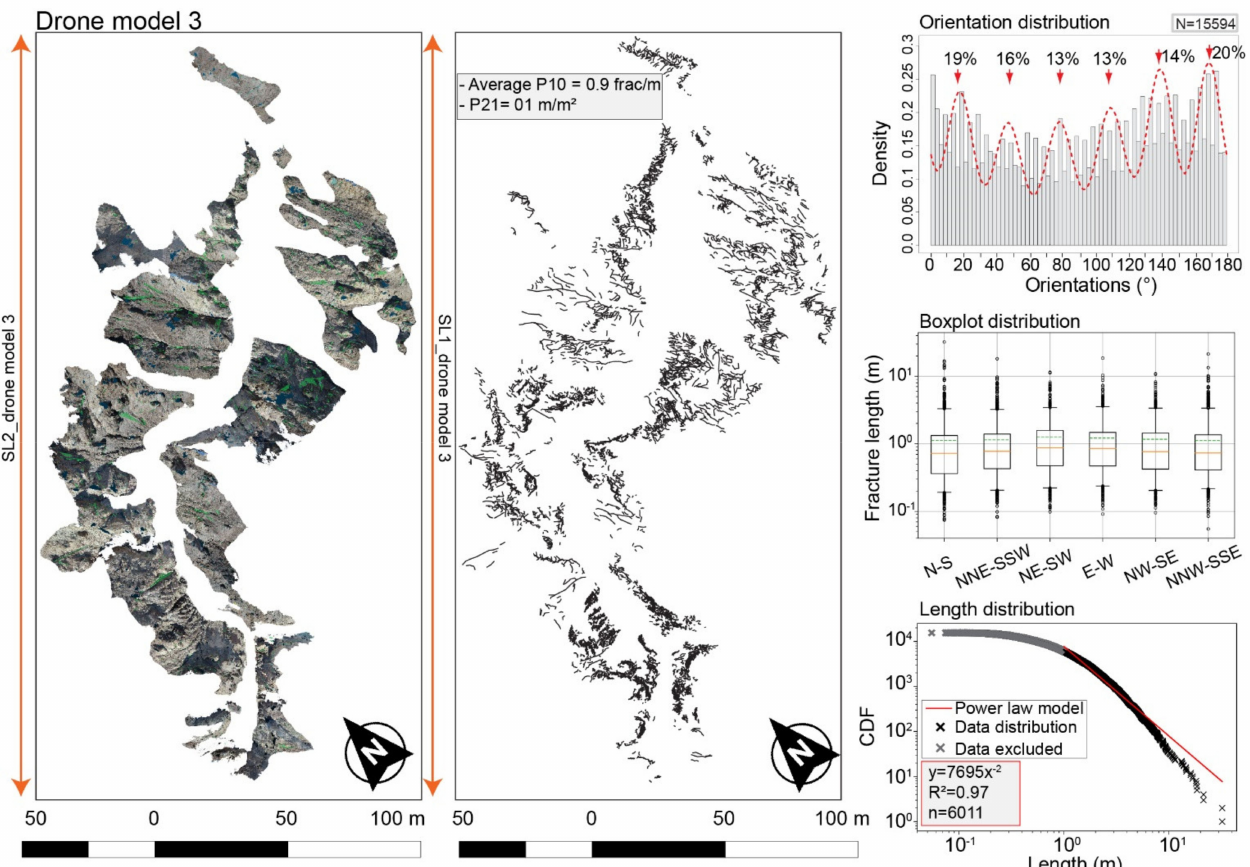
Figure 5. Fracture traces, orientation, boxplot length distributions from drone model 3. Different Datasets are expressed into histogram for orientation distribution, boxplot of length distribution according to the fracture orientations, and cumulative distribution function (CDF) of lengths. Two scanlines (SL) were taken along the left and the right side of the canyon. For Boxplot and orientation distribution legend, see Figure